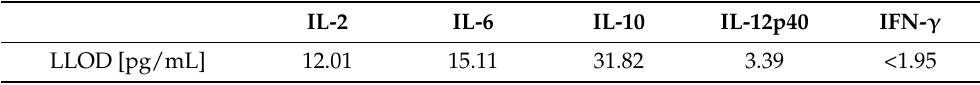
Table 3. Lower limit of detection